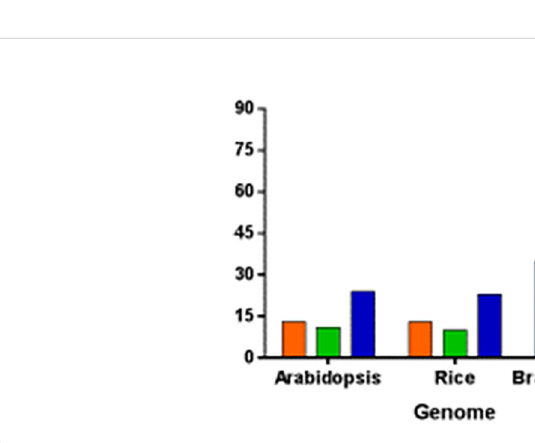
FIGURE 9 Genes encoding seven a and seven b subunit proteins of the 20S proteasome in Arabidopsis, rice and B. napus